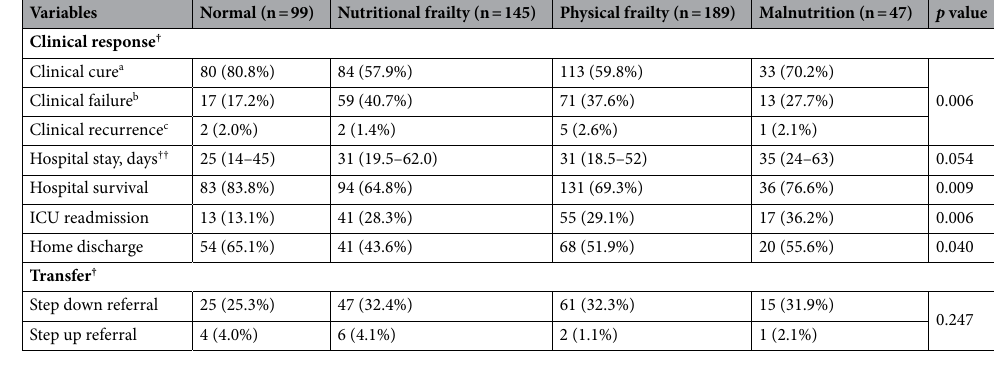
Table 2. Clinical outcomes according to phenotypes of frailty. Data are presented as mean ± standard deviation, median (IQR), or number (%). † Fisher’s exact test was conducted. †† Data are presented as median [interquartile range]. Kruskal–Wallis test was used. ICU intensive care unit, IQR interquartile range. a Improvement of all signs and symptoms associated with pneumonia. b Persistence or worsening of signs, symptoms, or both, associated with pneumonia, symptoms, signs of pneumonia, or both, occurring again within 3 days after termination of treatment. c Occurrence of a new event of pneumonia 72 h after antibiotic discontinuation.